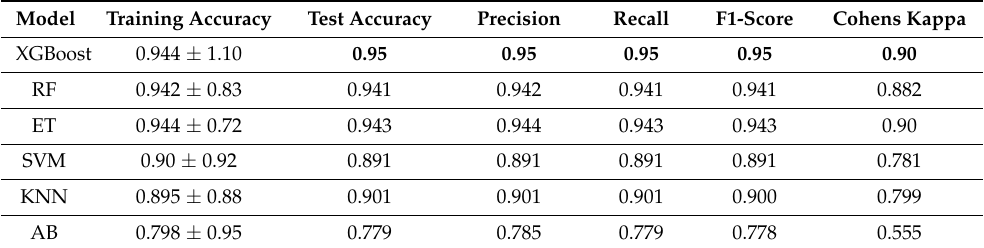
Table 6. Machine-learning model performances on training and test sets for two-class classification using all the features. The best performances are highlighted in